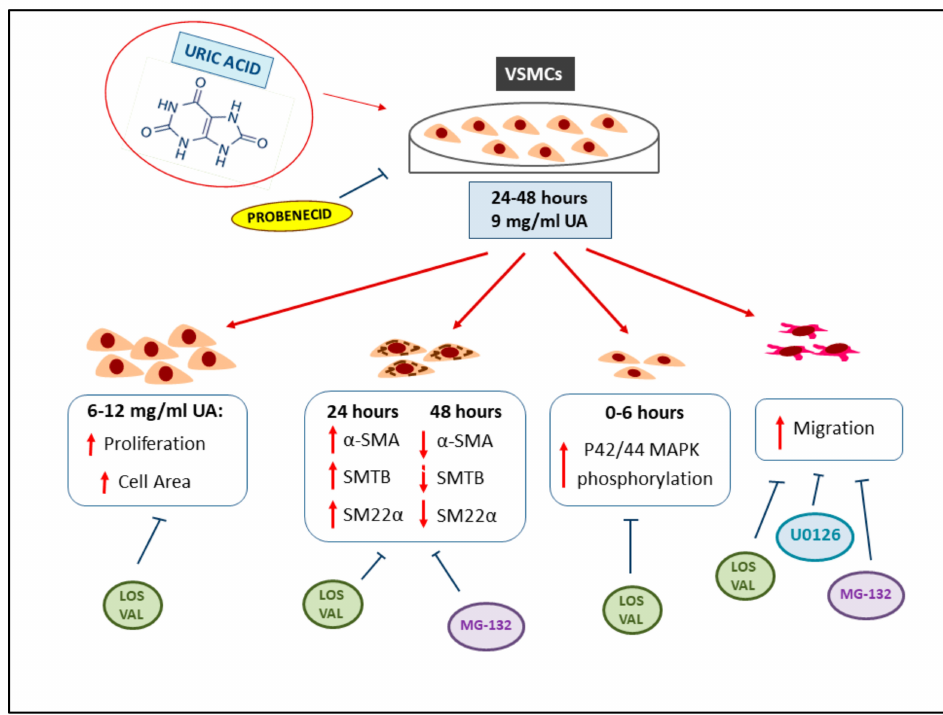
Figure 11. UA effects on VSMCs. The 24–48 h incubation of VSMCs with UA results in the increased area and proliferation of cells, changes in cytoskeleton protein expression, increased p42/44 MAPK phosphorylation and migration. The inhibitors used were able to block these processes induced by UA. Abbreviations: VSMCs = Vascular Smooth Muscle Cells; UA = Uric Acid; α -SMA = α -Smooth muscle actin; SMT B = Smoothelin B; SM22 α = Smooth Muscle 22 α ; MAPK = Mitogen-activated protein kinase; LOS = Losartan; VAL = Valsartan; MG-132 = proteasome inhibitor; U0126 = MEK